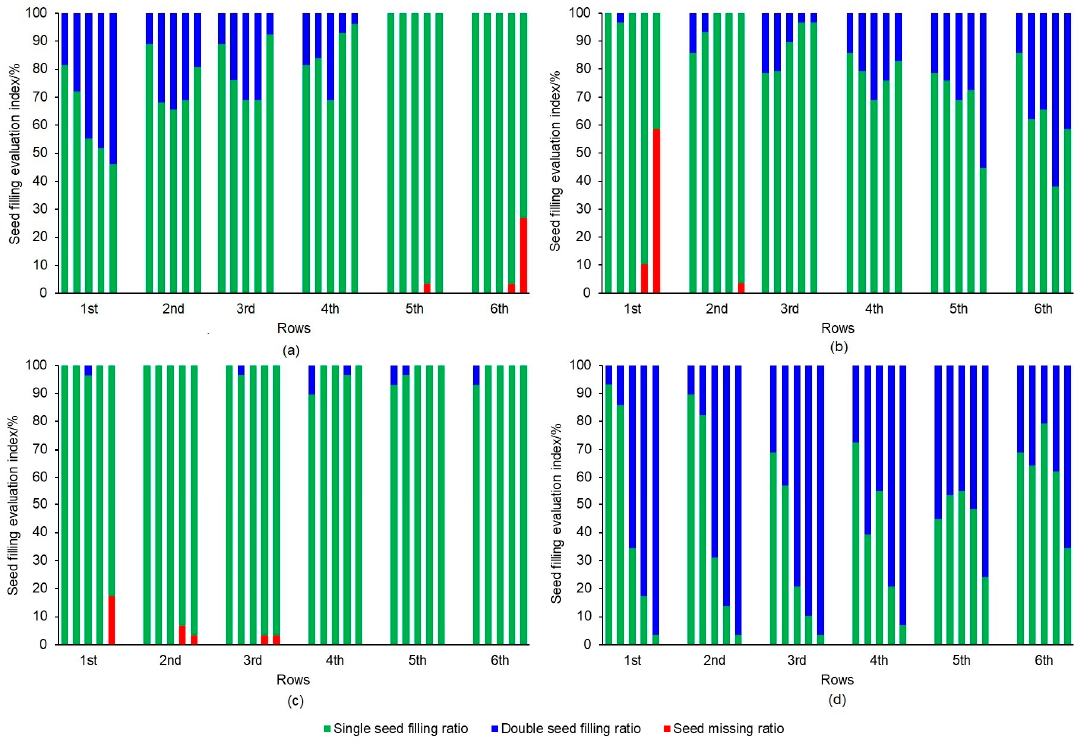
Figure 8. Effects of inclination angle on seed-filling performance for different rows: ( a ) tilting to − X direction, ( b ) tilting to X direction, ( c ) tilting to − Y direction, and ( d ) tilting to Y direction. The seeding indexes for each row from left to right represent the evaluation index of the inclination angles of 2°, 4°, 6°, 8°, and 10°.